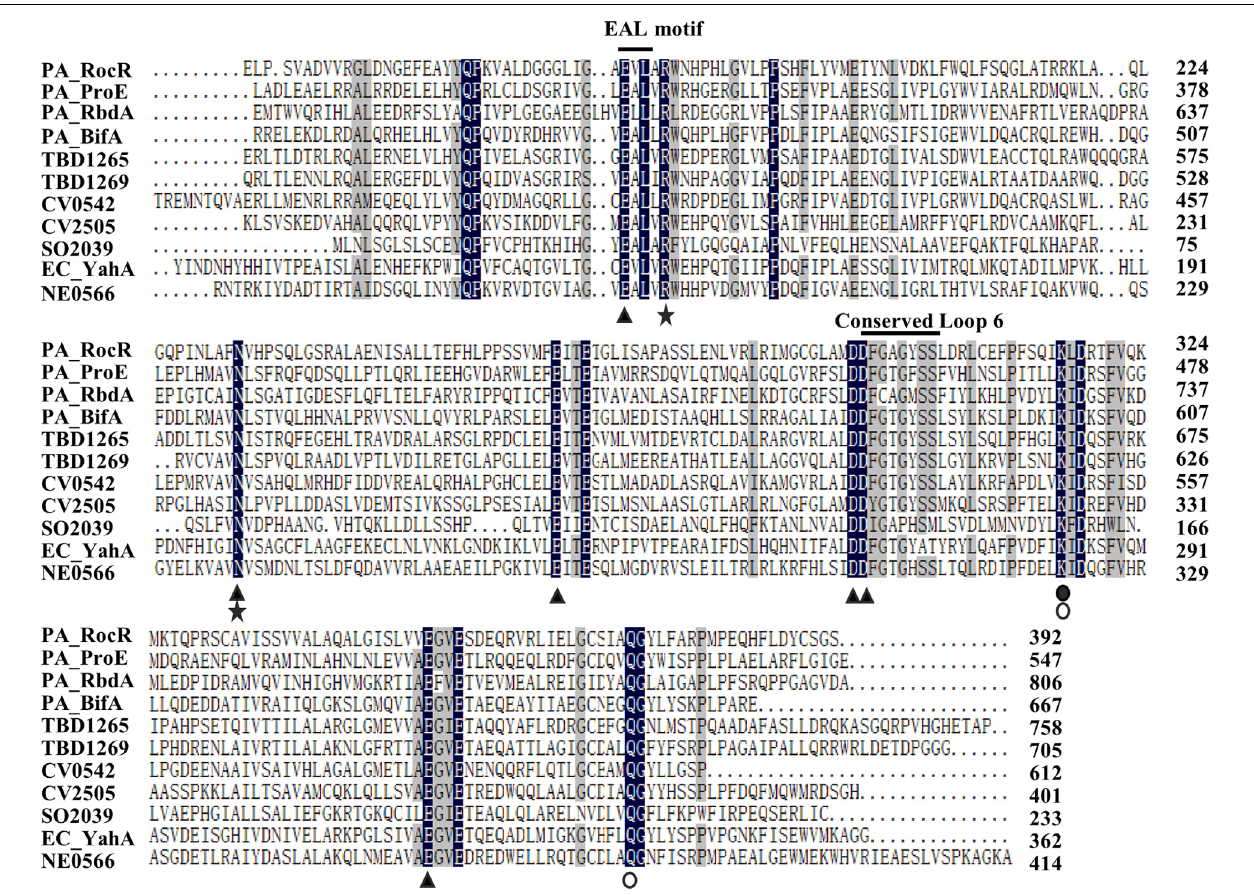
FIGURE 3 | Sequence alignment of EAL-containing phosphodiesterases. The amino acid sequence of RocR (Q9HX69), ProE (Q9HTQ9), RbdA (Q9I580), BifA (Q9HW35) from P. aeruginosa , TBD1265 (Q3SJE6), TBD1269 (Q3SJE2) from Thiobacillus denitrificans , CV0542 (Q7P0M4), CV2505 (Q7NV41) from Chromobacterium violaceum , SO2039 (Q8EFE2) from Shewanella oneidensis , YahA (P21514) from Escherichia coli, NE0566 (Q82WU5) from Nitrosomonas europaea. The amino acids highlighted with black stands for 100% similarity, and gray indicates similarity level ≥ 75%. E 328 , N 387 , E 419 , D 449 , D 450 , E 506 (filled triangle) are conserved residues which may bind to metal ion (Tamayo et al., 2005; Rao et al., 2008; Tchigvintsev et al., 2010; Yang et al., 2017). The conserved loop 6 (DFG(T/A)GYSS) is essential for the dimerization of EAL domain and Mg 2 + , c-di-GMP binding (Rao et al., 2009). R 332 , N 387 are (asterisks) reported to bind with substrate (Rao et al., 2008; Tchigvintsev et al., 2010; Yang et al., 2017). K 470 (filled circle) is essential for coordinating with water molecule for catalysis and interacting with residue E 419 residue (Rao et al., 2008; Tchigvintsev et al., 2010; Yang et al., 2017). Q 526 is reported to interact with E 328 and K 470 (open circle) (Tchigvintsev et al., 2010; Yang et al.,